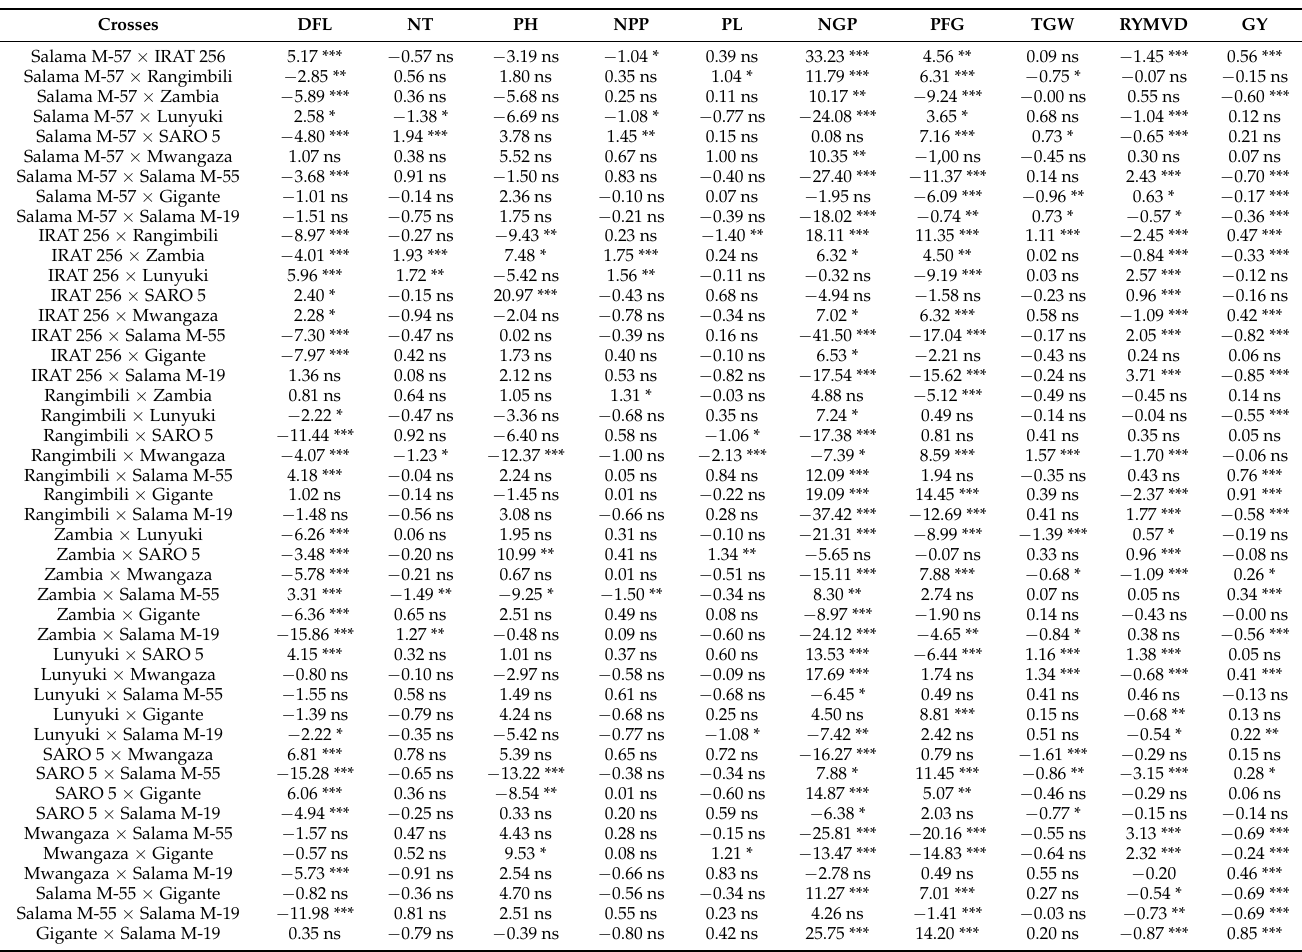
Table 8. Specific combining ability effects for agronomic traits and RYMVD reaction among 45 crosses assesed in three sites in Tanzania. Crosses Salama M-57 × IRAT